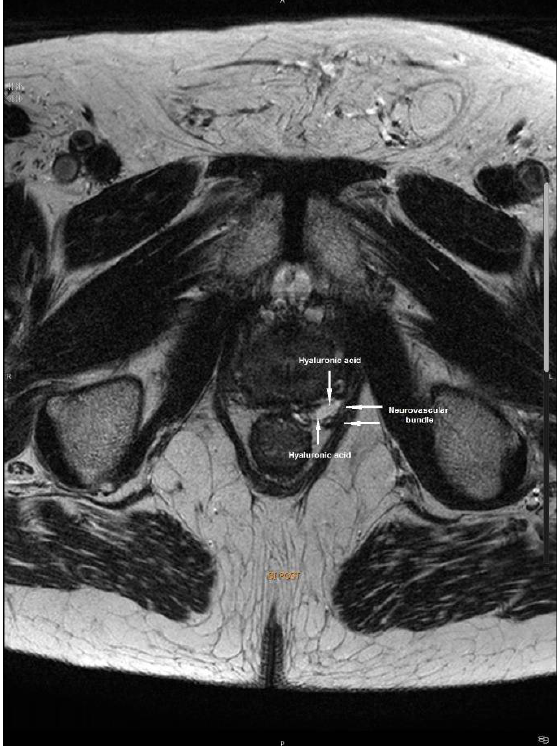
Figure 2. Magnetic resonance image demonstrating the additional space between the prostate capsule and neurovascular bundle.